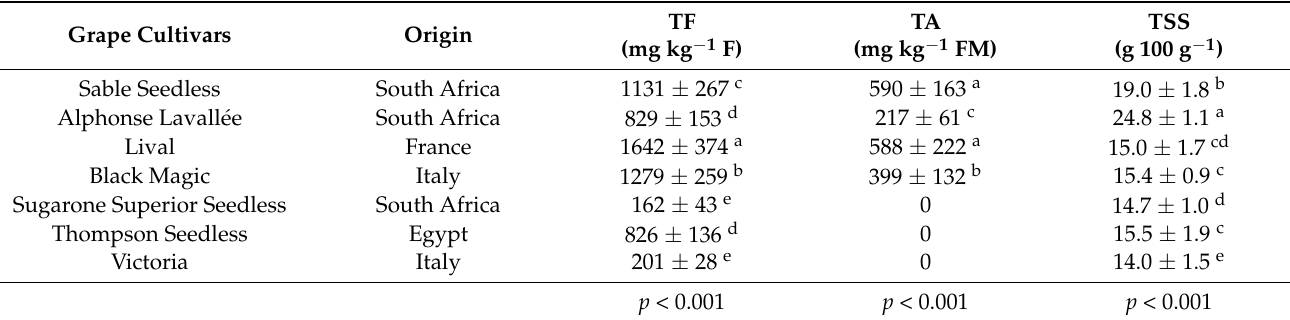
Table 1. Grape composition. Total Anthocyanins (TA), Total Flavonoids (TF) Content, and Total Soluble Solids (TSS) of table grapes. a b c , and d letters within the same column indicate significant differences among table grape cultivars according to Tukey-b test ( p < 0.05). FW: fresh